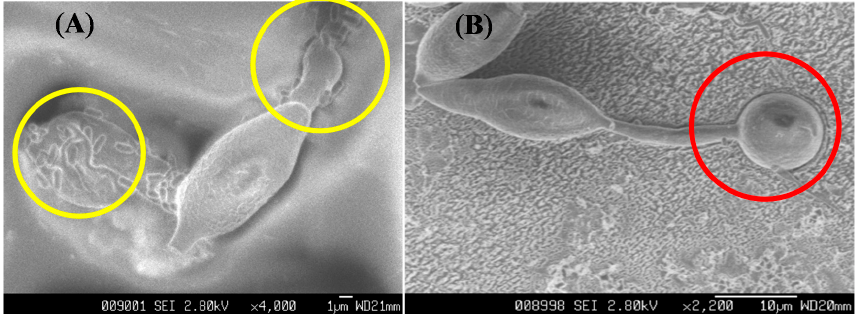
Figure 6. When the deformed germ tubes were treated with Ba-BPD1 broth, no appressoria was observed ( A ). The appressoria was formed at the tips of the germ tube when conidia of P. oryzae germinated on the host ( B